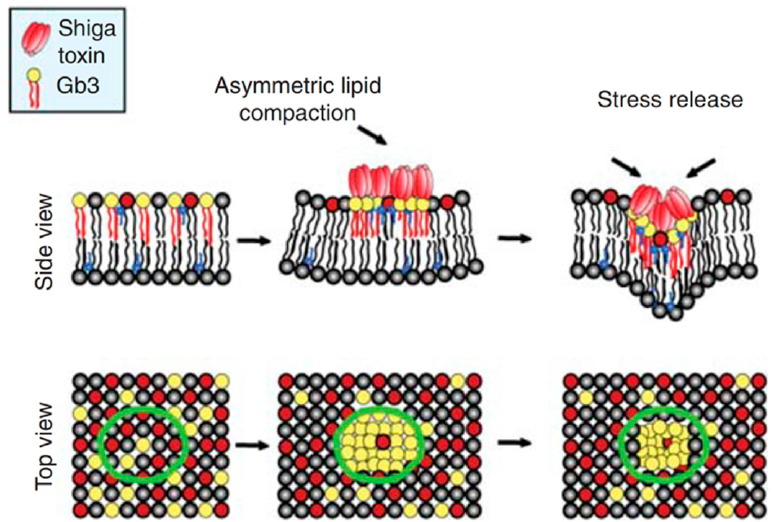
Figure 4. Hypothesis on asymmetric compressive stress leading to negative membrane curvature. Membrane compression of the exoplasmic leaflet to which STxB is bound will force the double- layered plasma membrane to curve in the direction of the toxin. From Reference [20]; courtesy of the Cold Spring Harbor Laboratory Archives.